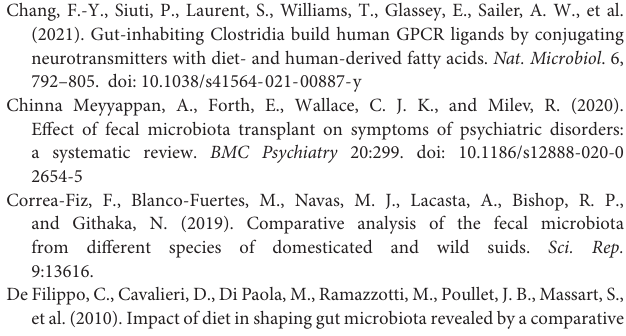
decrease accuracy of each bacteria genus in the model. Supplementary Table 4 | Random forest model constructed for classification the mice treated with low-fiber and high-fiber diet, the mean